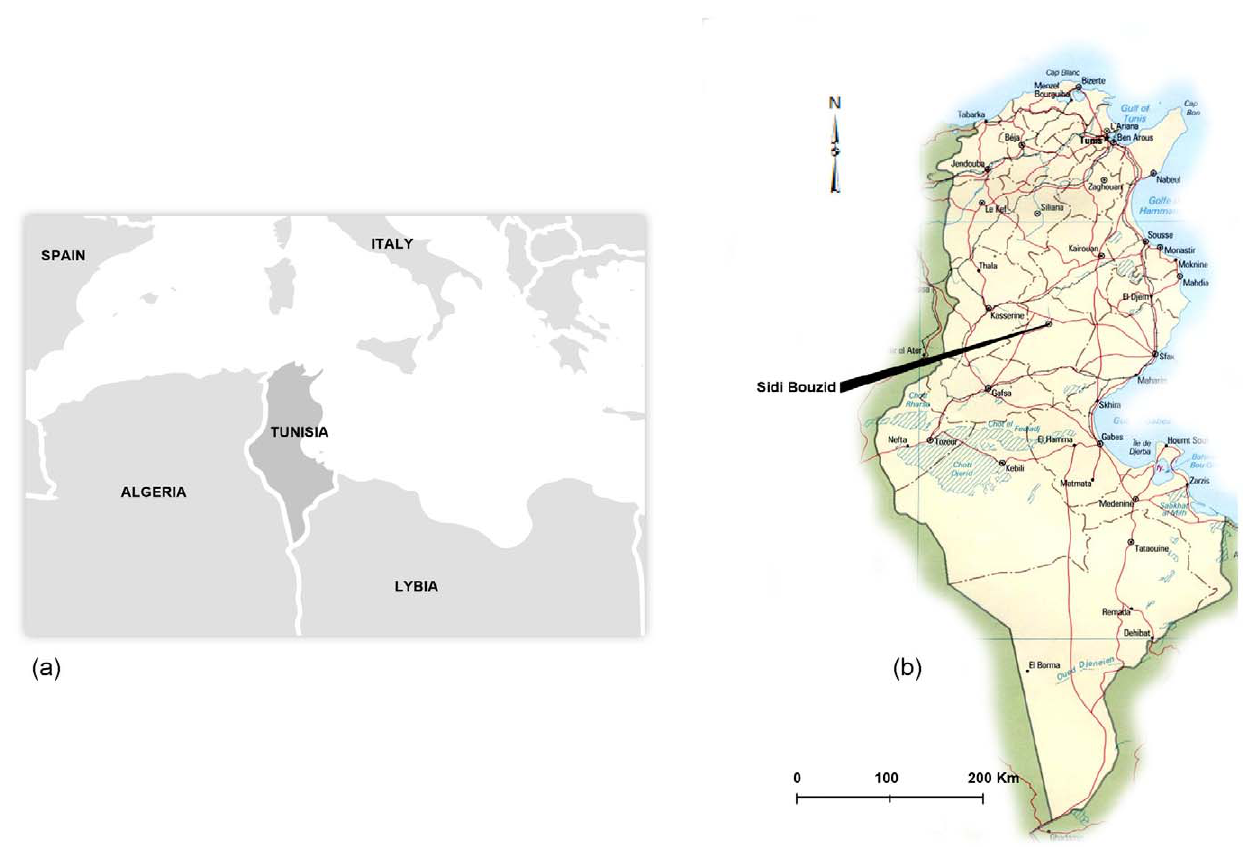
Figure 1. Location of study area. (a) Tunisia Location Within Mediterranean Basin. (b) Location of Sidi Bouzid Governorate Within Tunisia.